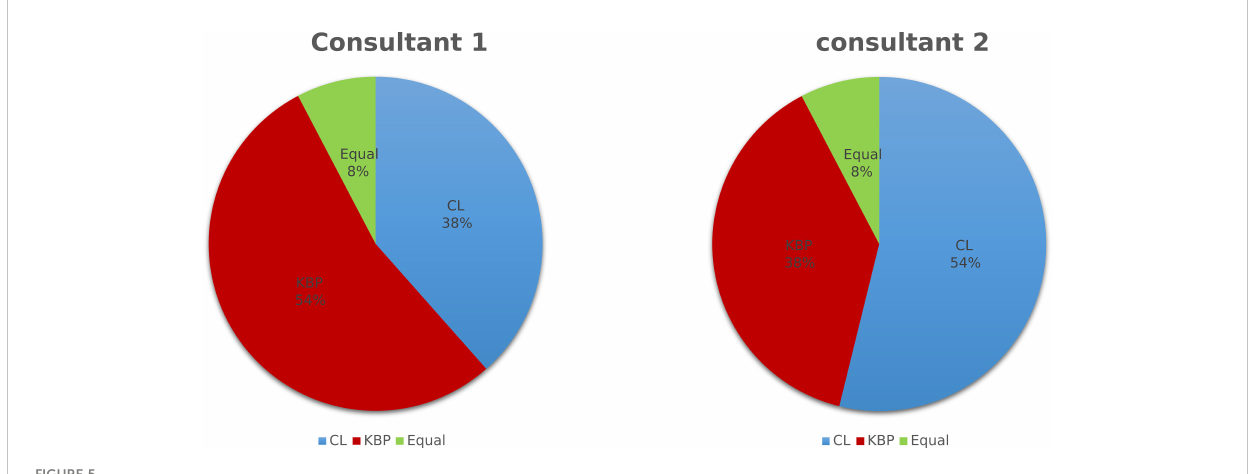
FIGURE 5 Blinded review result for 26Gy in 5 fractions.